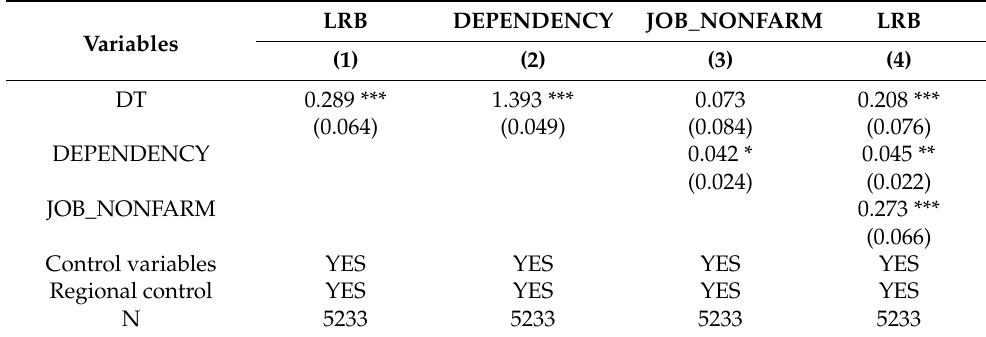
Table 5. Results of CMM model of DT’s impact on